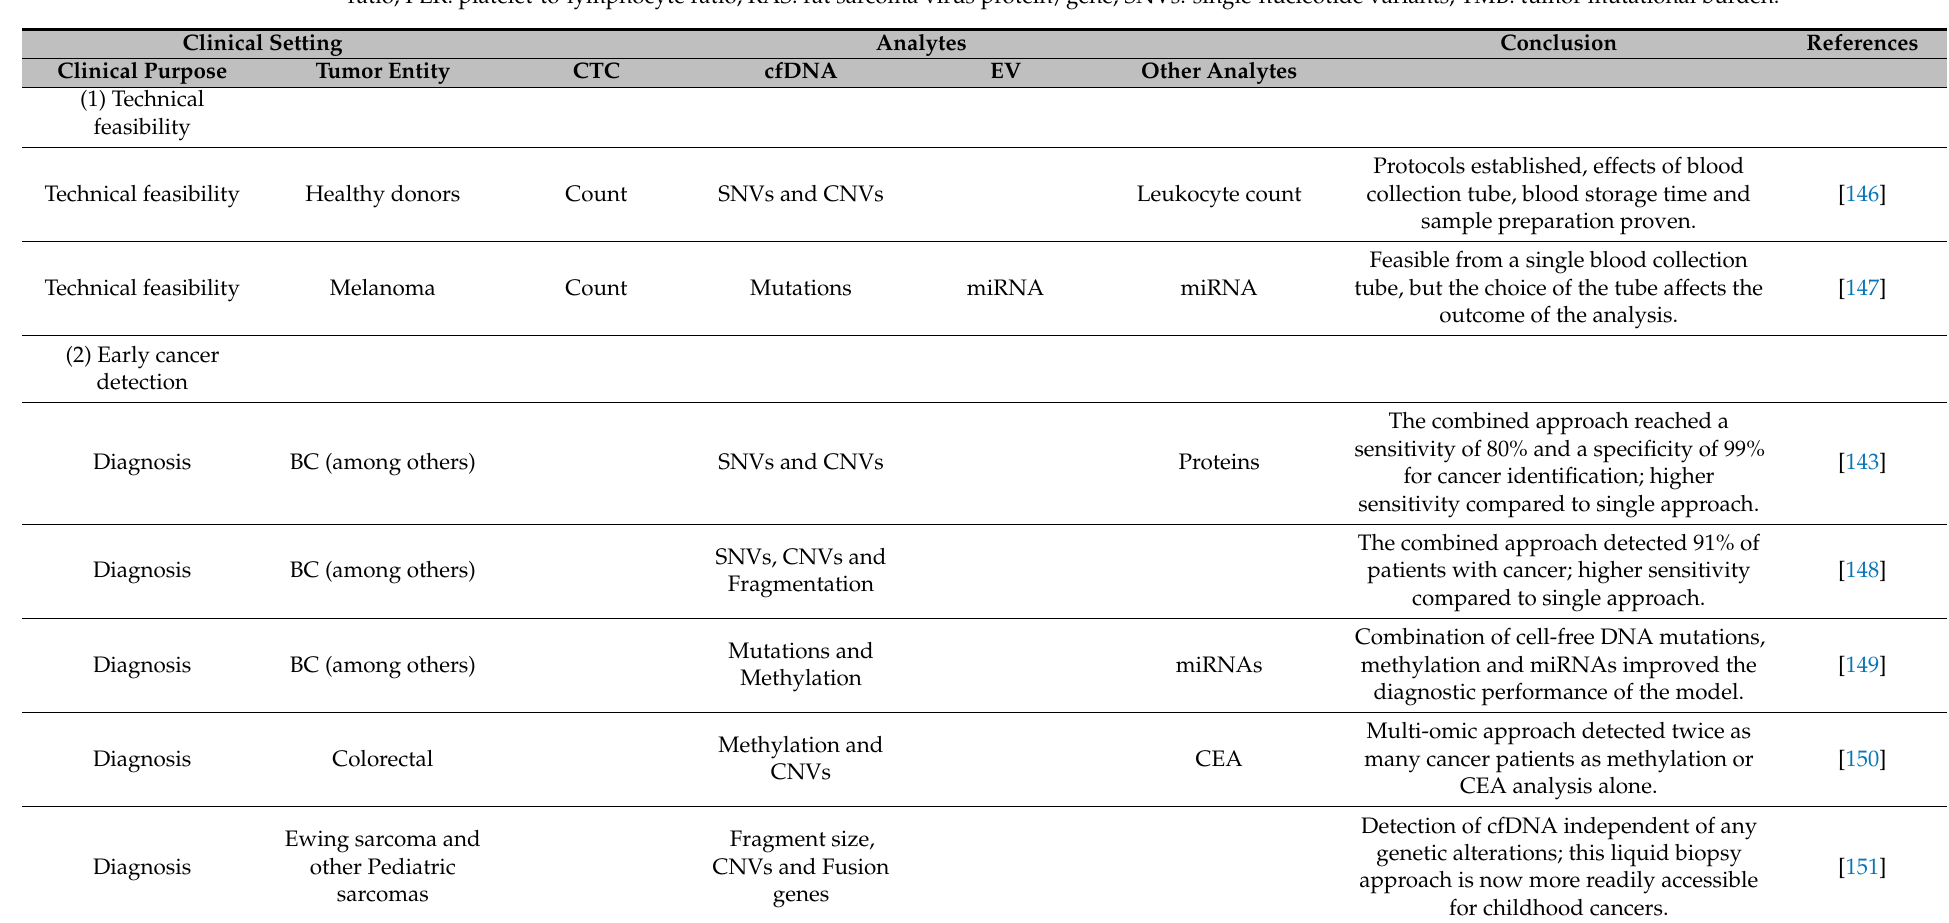
Table 2. Multimodal liquid biopsy studies. All publications describing a parallel analysis of more than two liquid biopsy analytes from matched samples are listed and separated according to the clinical purpose. Abbreviations: AR: androgen receptor; BC: breast cancer; CA19-9: carbohydrate antigen 19-9; CEA: carcinoembryonic antigen; cfDNA: cell-free DNA; cfRNA: cell-free RNA; CNVs: copy number variations; CTC: circulating tumor cell; EV: extracellular vesicle; HER2: